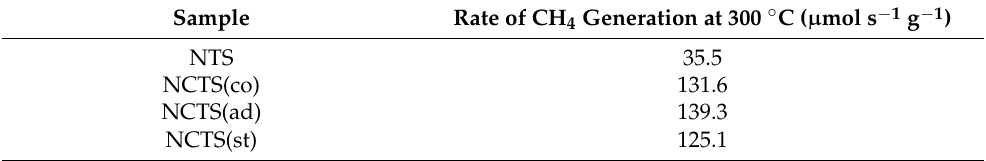
Table 1. Rate of CH 4 generation.